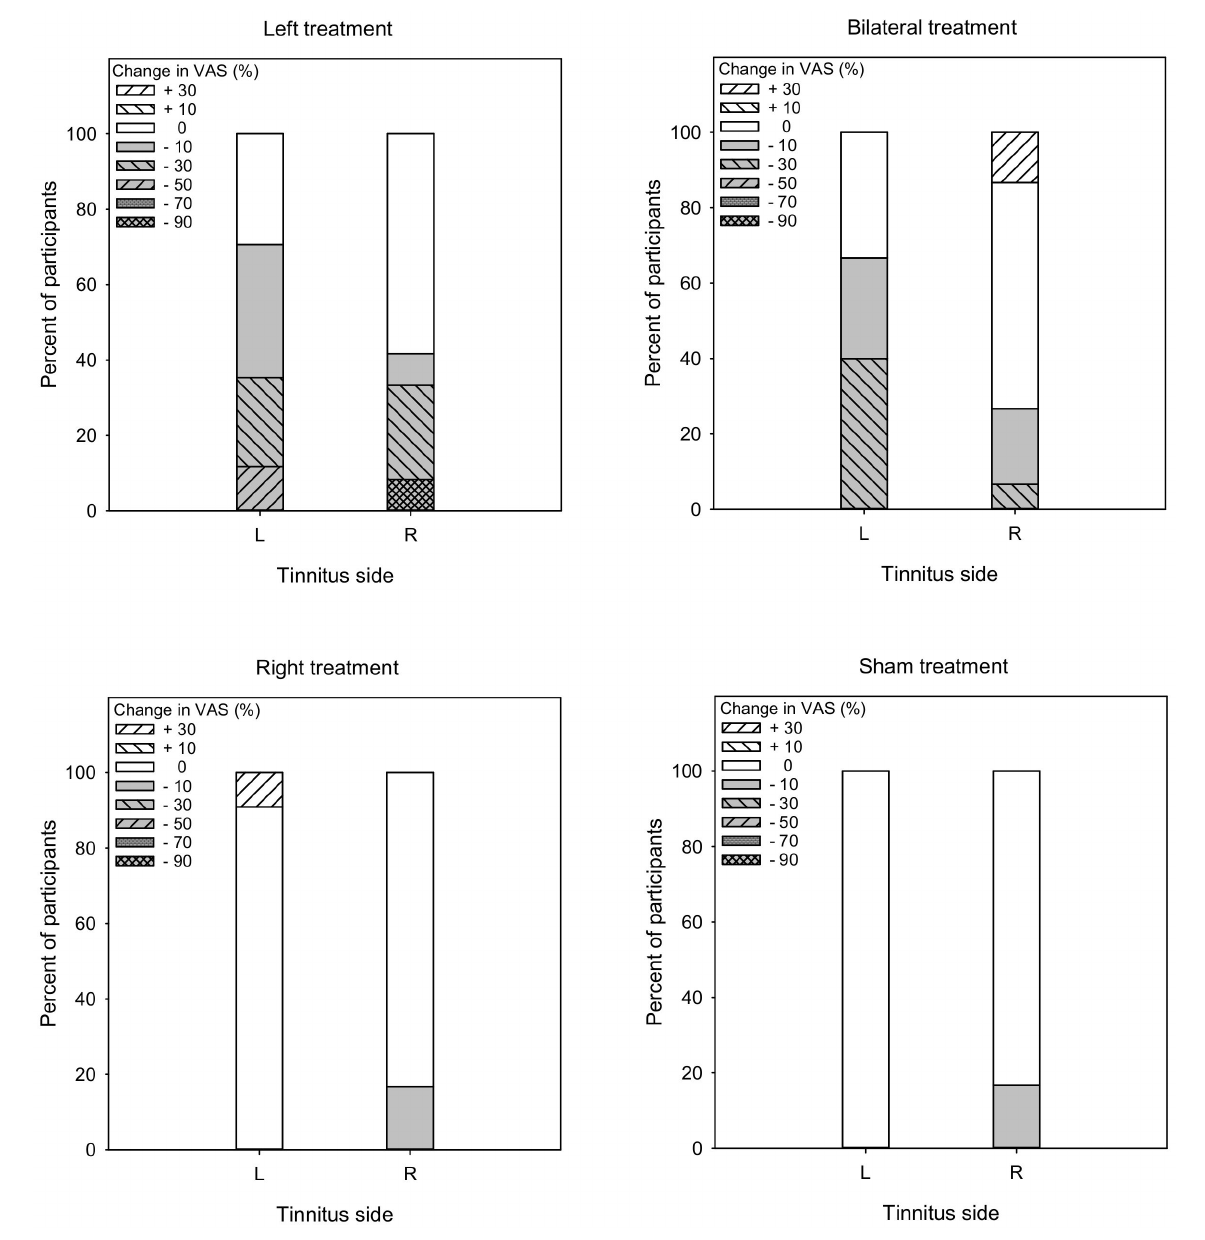
Figure 7. Vertical stacked bar charts showing the percentage of patients with various ranges of post- treatment changes in VAS scores the Left, Right, Bilateral, and Sham treatment groups. Reductions >10% were considered to be responders (gray bars), and reductions <10% were considered non- responders (white